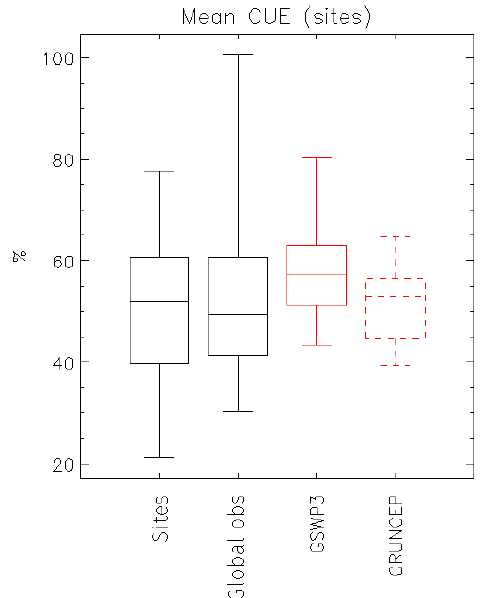
Figure 17. Mean annual CUE (%) over the 52 Campioli sites, aver- aged over the period 2000–2007. The first black boxplot is com- puted using the local estimations of the Campioli et al. (2015) database and the second one (global observations) using MODIS- NPP and MTE-GPP. The red boxplots use the values of the two sim- ulations. For each boxplot the median value is the short horizontal bar within the rectangle, whose bottom and top sides illustrate the 25th and 75th percentiles of the distribution, while the vertical seg- ments link those sides to the points representing, respectively, the minimum and maximum